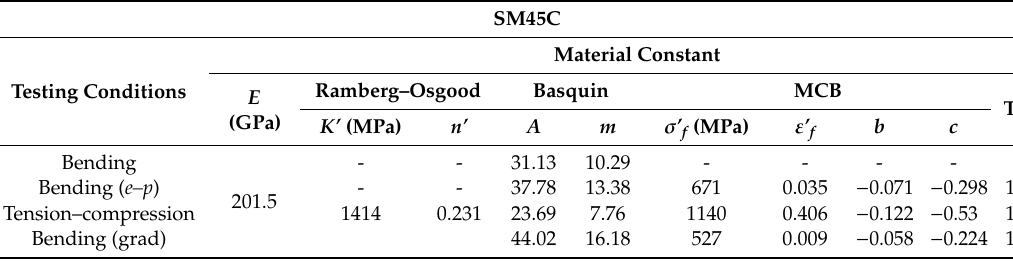
Table 5. Cyclic properties of SM45C.